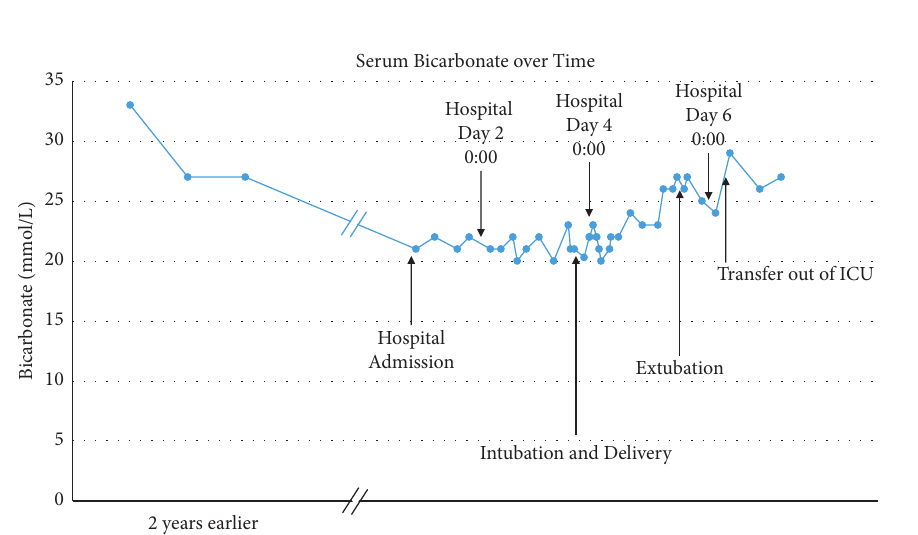
Figure 1: Serum bicarbonate changes from preconception to postpartum. ICU, intensive care unit; L, liter; mmol,